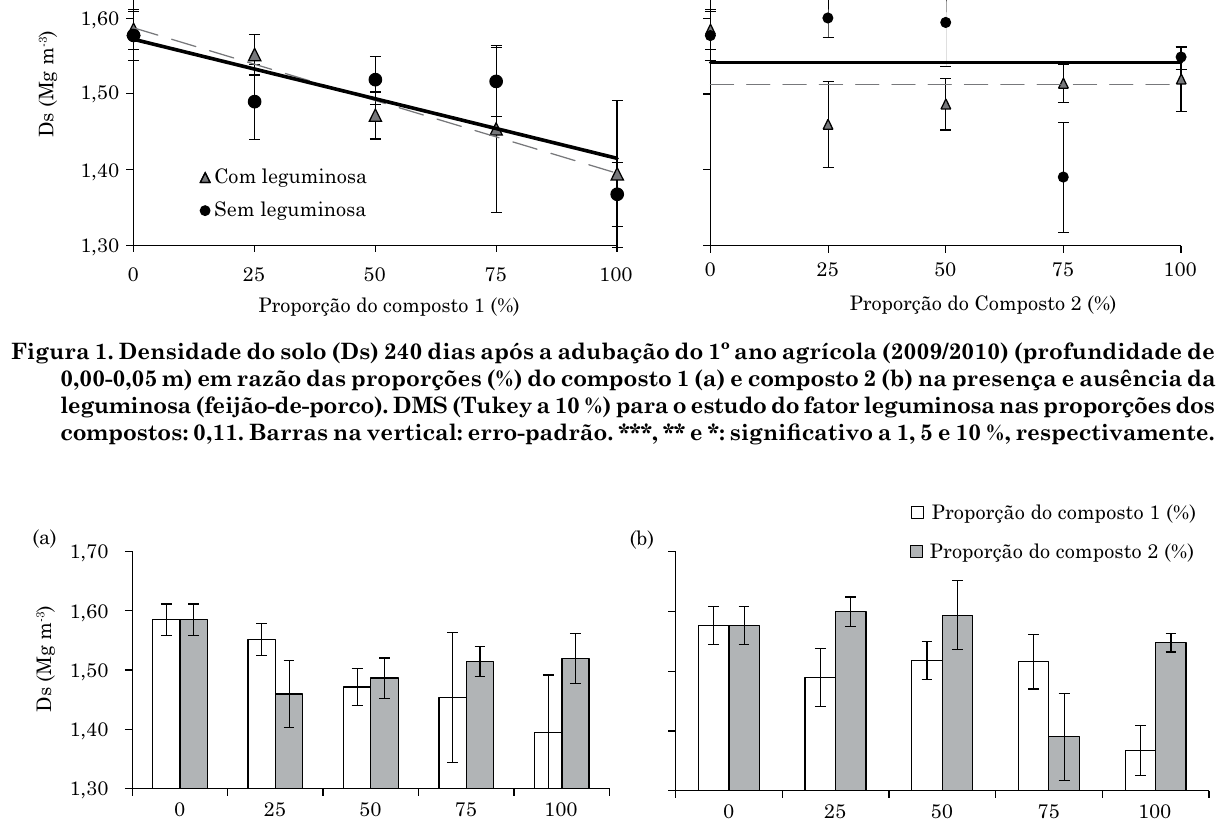
Figura 2. Densidade do solo aos 240 dias após a adubação do 1º ano agrícola (2009/2010) (profundidade de 0-5 cm) em razão do tipo de composto orgânico na presença (a) e ausência (b) da leguminosa. Barras na vertical: erro-padrão. DMS (Tukey a 10 %) para o estudo do fator “composto” em suas respectivas proporções: